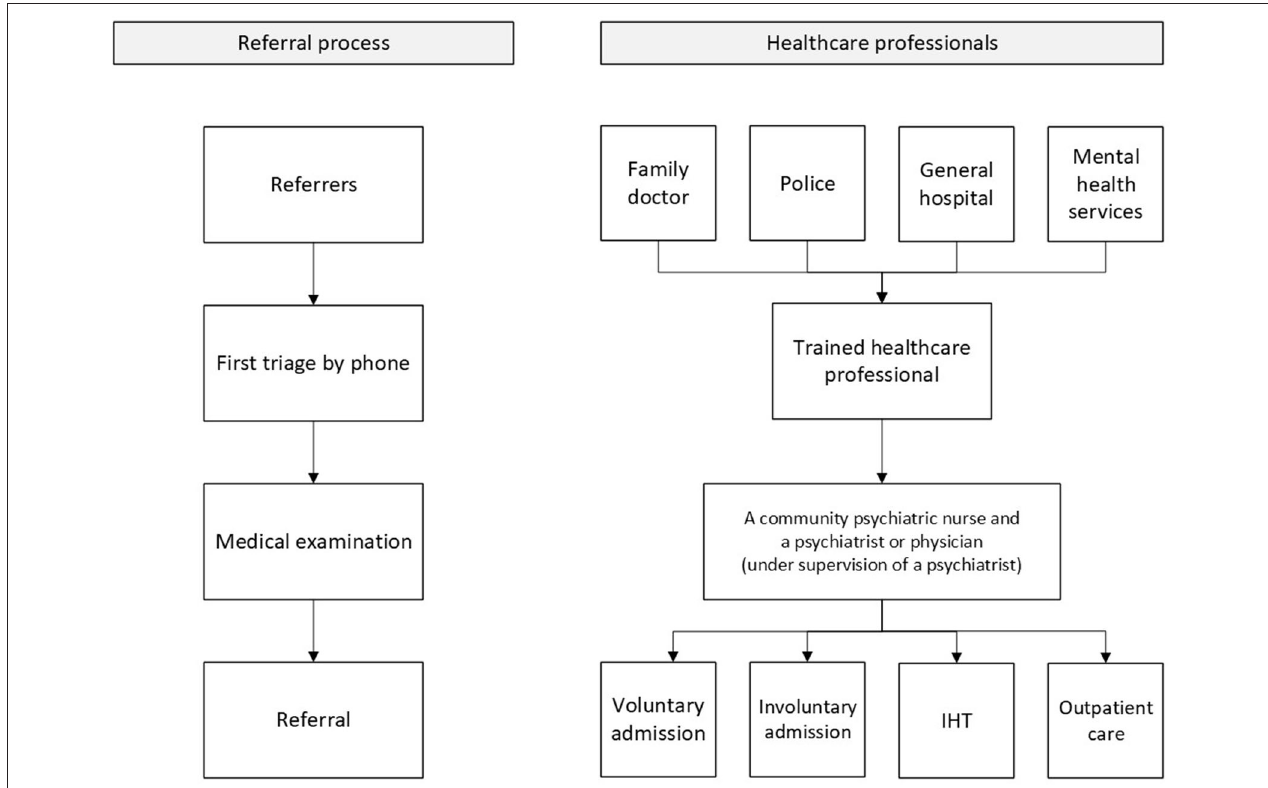
FIGURE 1 | Referral